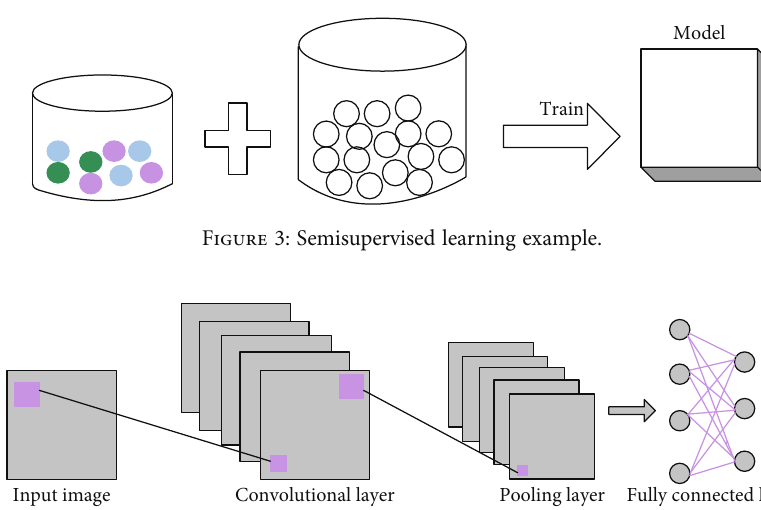
Figure 4: Flowchart of the convolutional neural